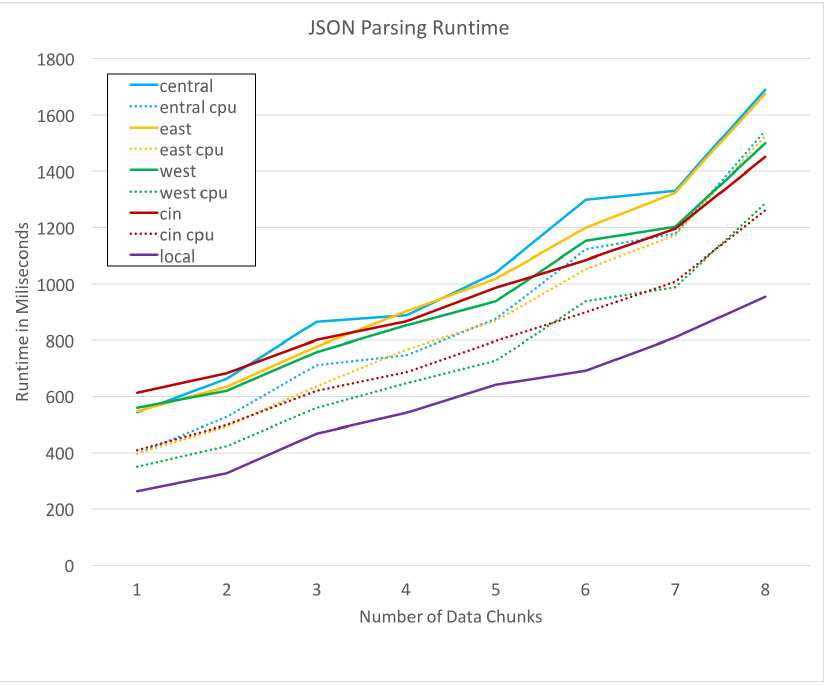
Figure 6. Run-times of JSON parsing for each